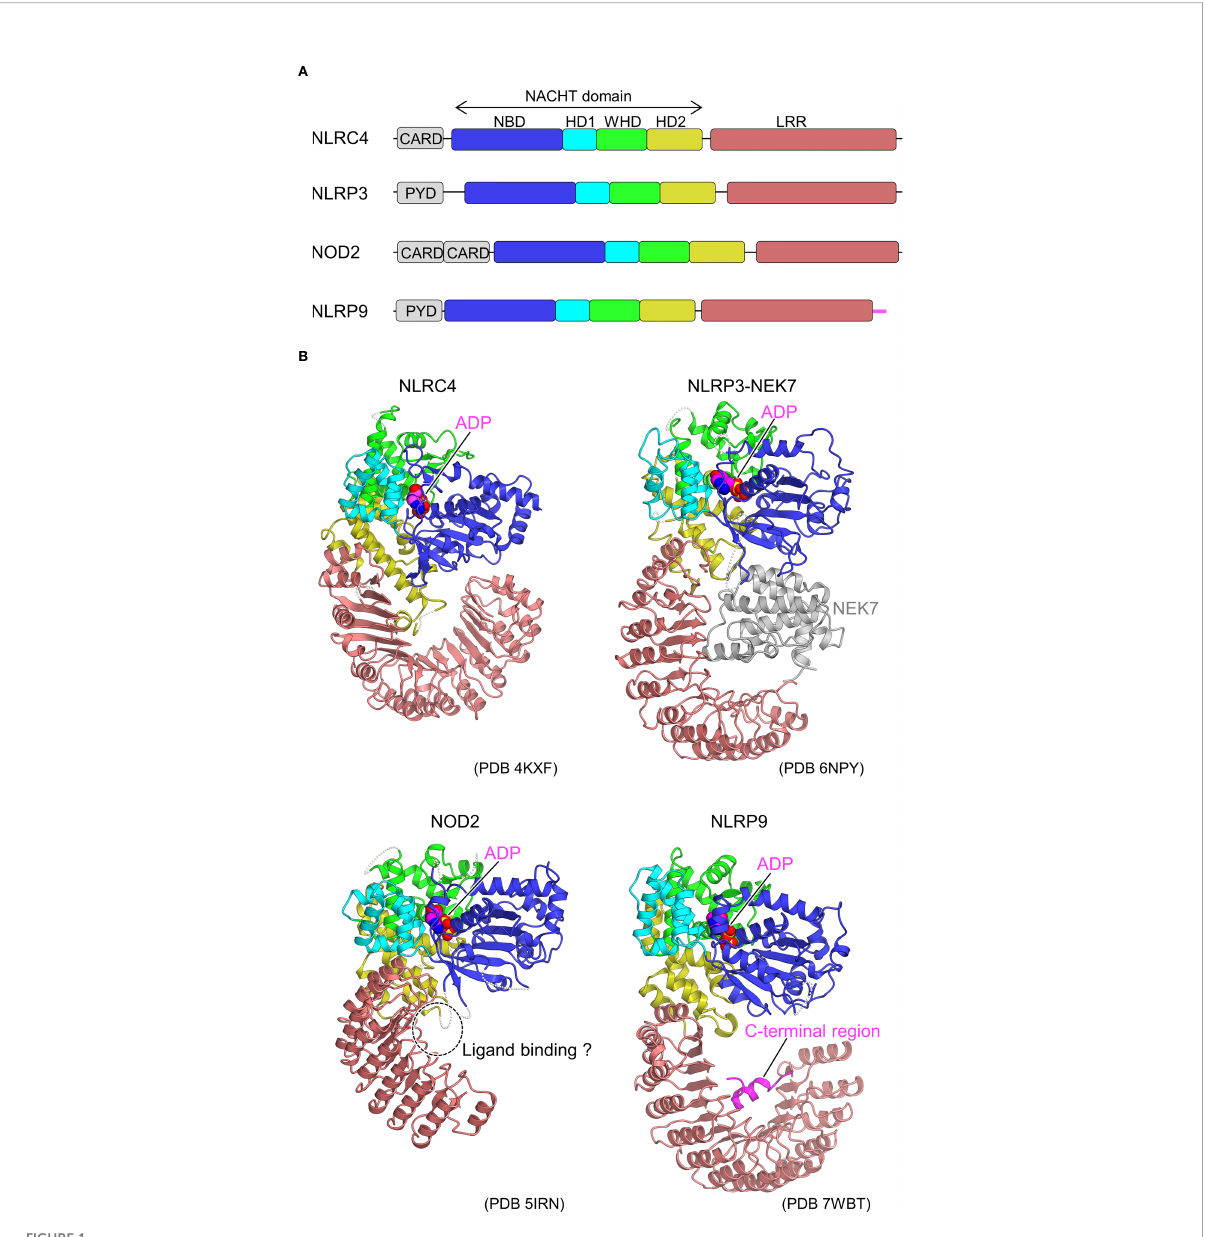
FIGURE 1 Domain organization and structures of inactive NLRs. (A) Domain organization of NLRs. Each of the domains and sub domains are indicated by the different colors and are correspondingly indicated in Figure 1B. (B) , Structures of inactive NLRs. Structures of inactive NLRC4 (PDB 4KXF) (16), NLRP3-NEK7 complex (PDB 6NPY) (36), NOD2 (PDB 5IRN) (29), and NLRP9 (PDB 7WBT) (30) are shown with the domains colored as per (A) . Bound ADP molecules are shown in space fi lling representations. In the NLRP3-NEK7 complex, bound NEK7 is shown in gray. The potential ligand-binding site in NOD2 and the C-terminal region of NLRP9 are indicated. Structural fi gures were generated using CueMol throughout this review